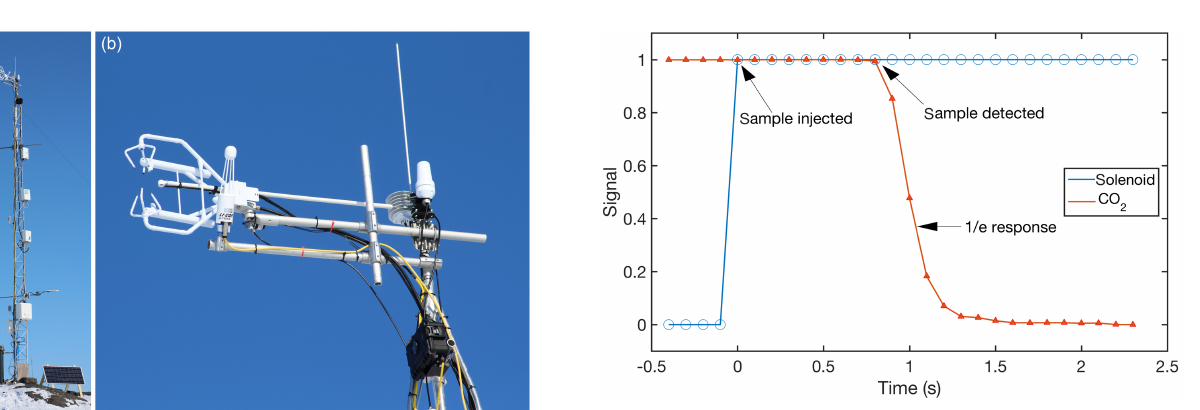
Figure 2. Photograph of the tower (a) and the flux instruments mounted at the top of the tower (b) .